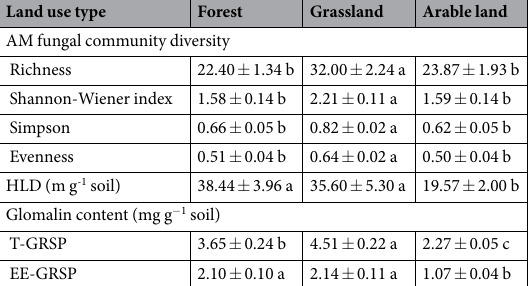
Table 2. Diversity indices of AM fungal community, hyphal length density (HLD) and glomalin content in soils of three different land use types. Data are mean ± SE (n = 15). Means followed by the same letter do not differ significantly at P ≤ 0.05 by Duncan’s multiple range